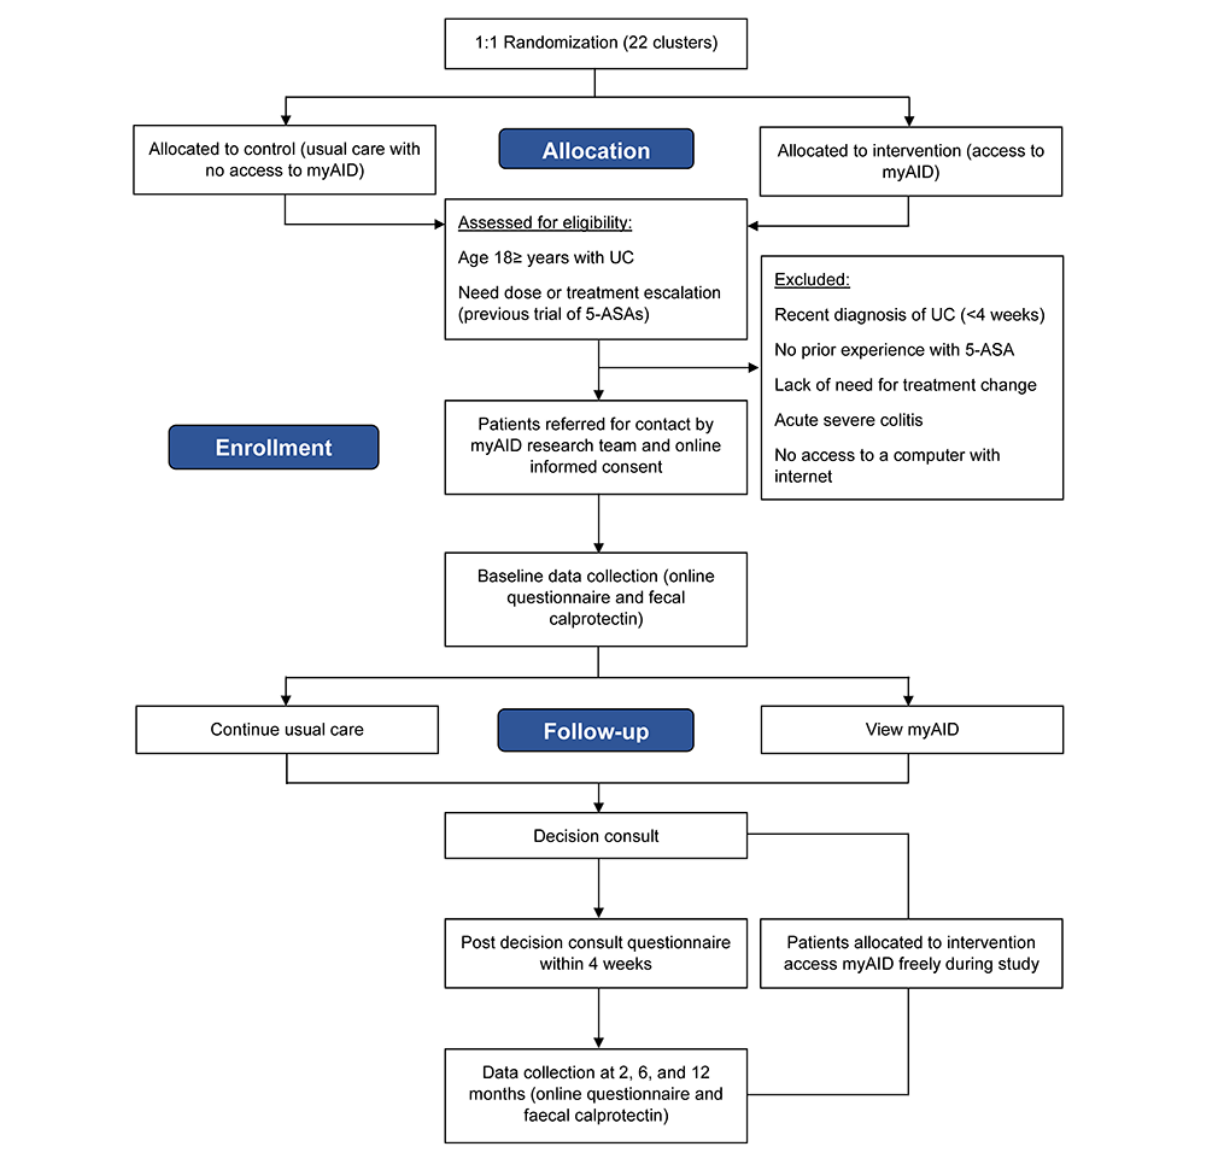
Figure 1. myAID study flowchart. 5-ASA: 5-aminosalicylates; UC: ulcerative colitis; myAID: my Actively Informed Decision. *Decision consult, if arranged, will be arranged within 2-4 weeks of referral. **Post decision consult (if arranged) or follow-up questionnaire to be completed within 2-4 weeks of